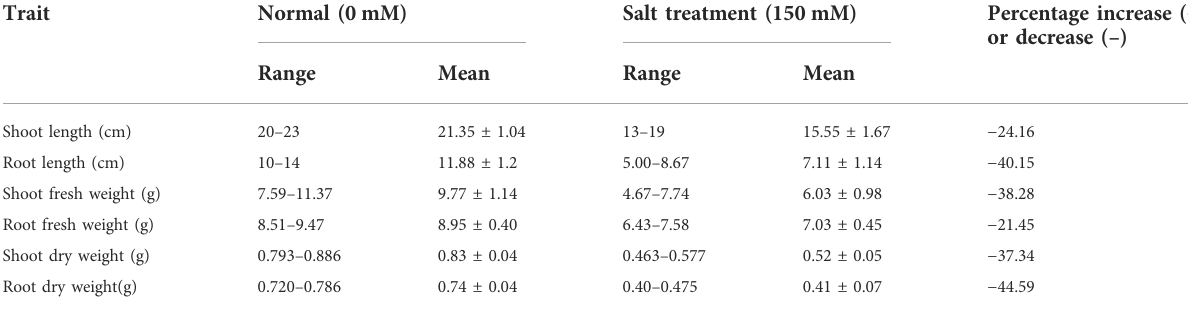
TABLE 2 Range, mean, and percentage change in seedling traits of 125 genotypes under control (0 mM) and salinity (150 mM).